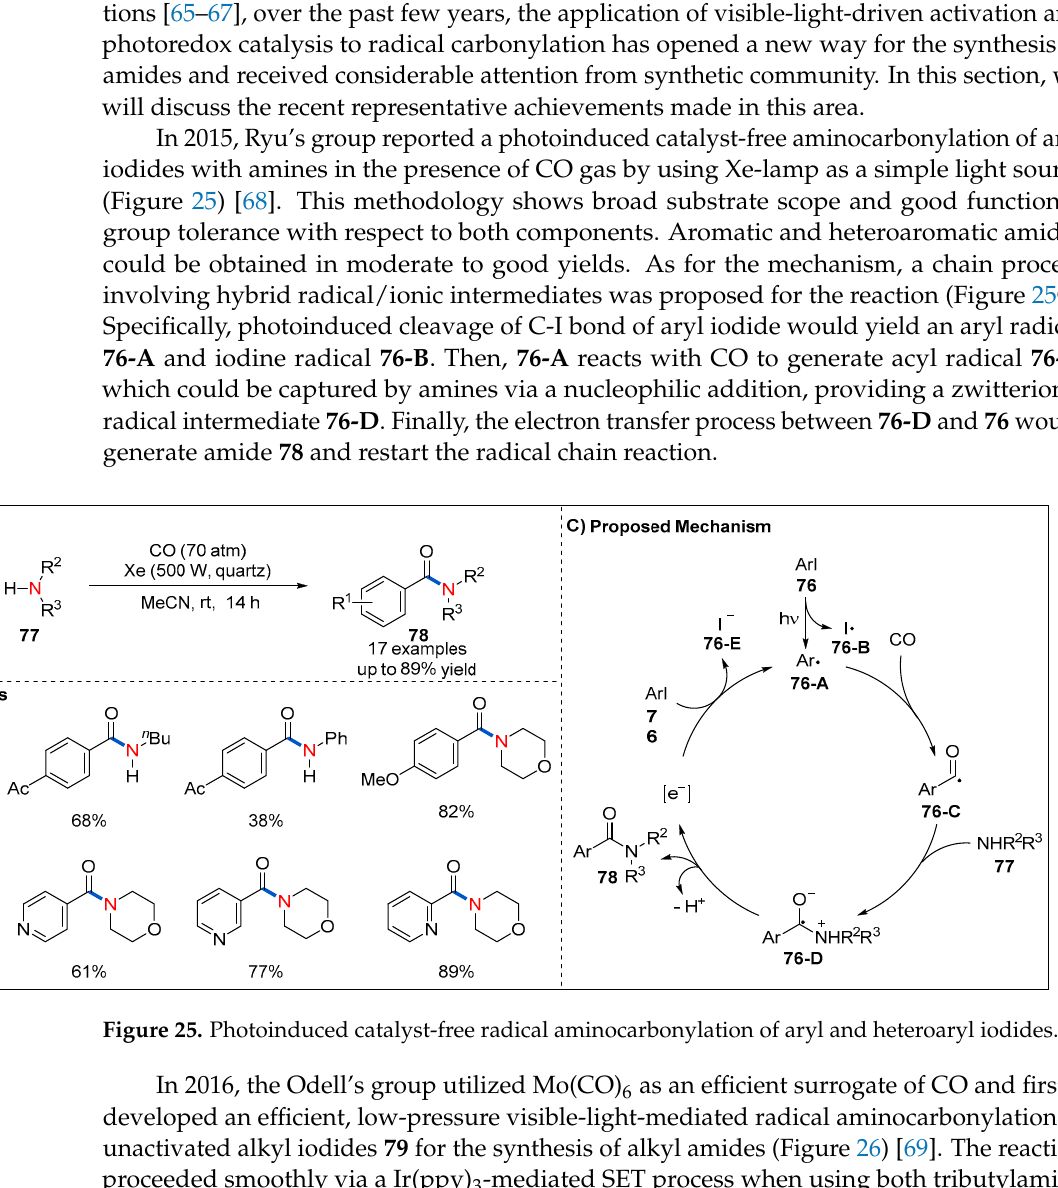
Figure 26. Photoinduced radical aminocarbonylation of unactivated alkyl iodides under low pres- sure of ex situ-formed CO.